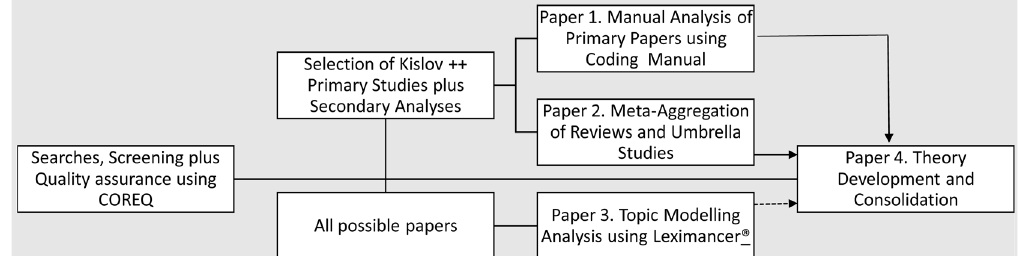
Figure 2. Workflow and synthesis